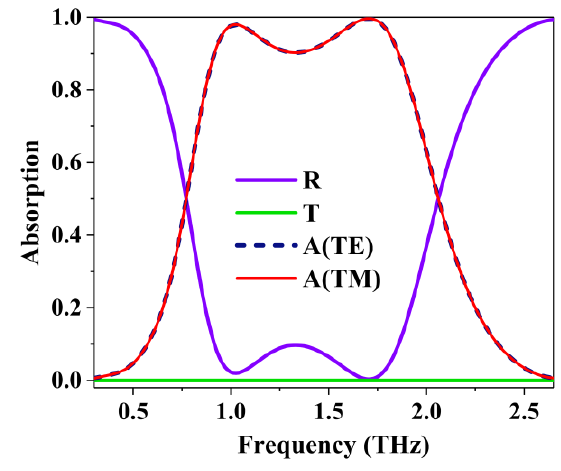
Figure 2. Transverse electric (TE) mode and transverse magnetic (TM) mode reflection (R), transmission (T), and absorption (A) spectra.